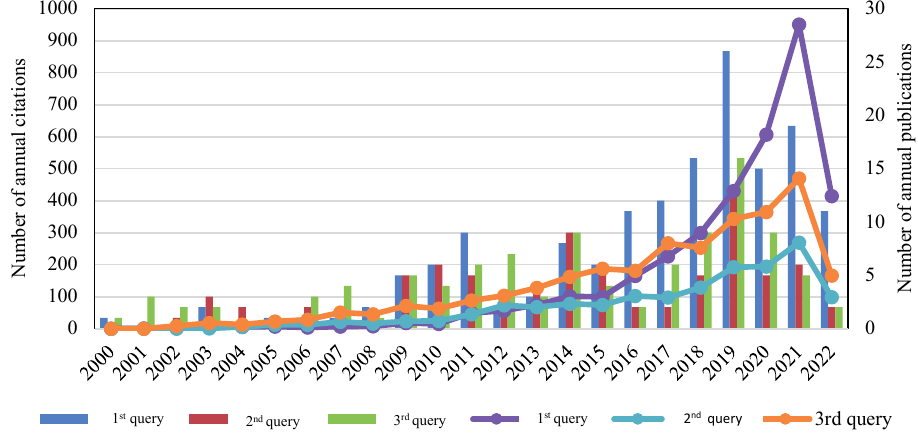
Fig. 2. Overall trend in the number of scientific publications published and cited for the queries. Similar trend as for number of publications is observed for number of citations of the search queries. The highest total number of citations during the period from 2000 to 2022 was for 1 st query (3536 citations), followed by 3 rd query which had 3026 citations. 2nd query had significantly lower total number of citations (1530 citations) than 1st and 3 rd query. Both the number of publications and the number of citations show that the keyword combination ‘energy-economy-environment’ modelling is less frequent than more general searches for climate-economy-modelling links. In general, a significant gradual increase in the number of scientific publications published and cited each year can be observed starting from